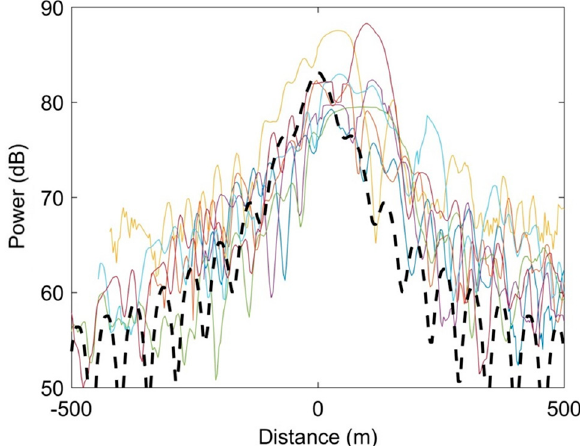
Figure 17. Theoretical RCS (dashed black) overlaid on the seven altimeter passes. Different colors are used to distinguish between the different satellite passages.